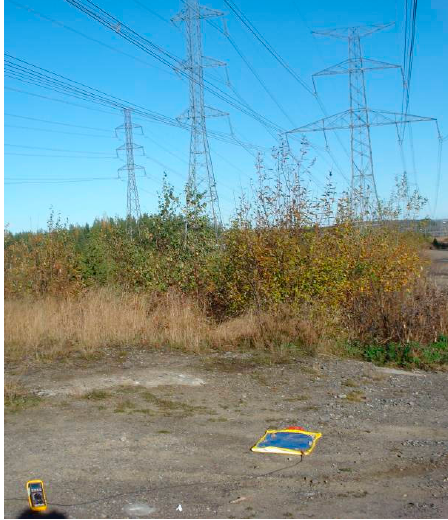
Figure 1. Experiment location.